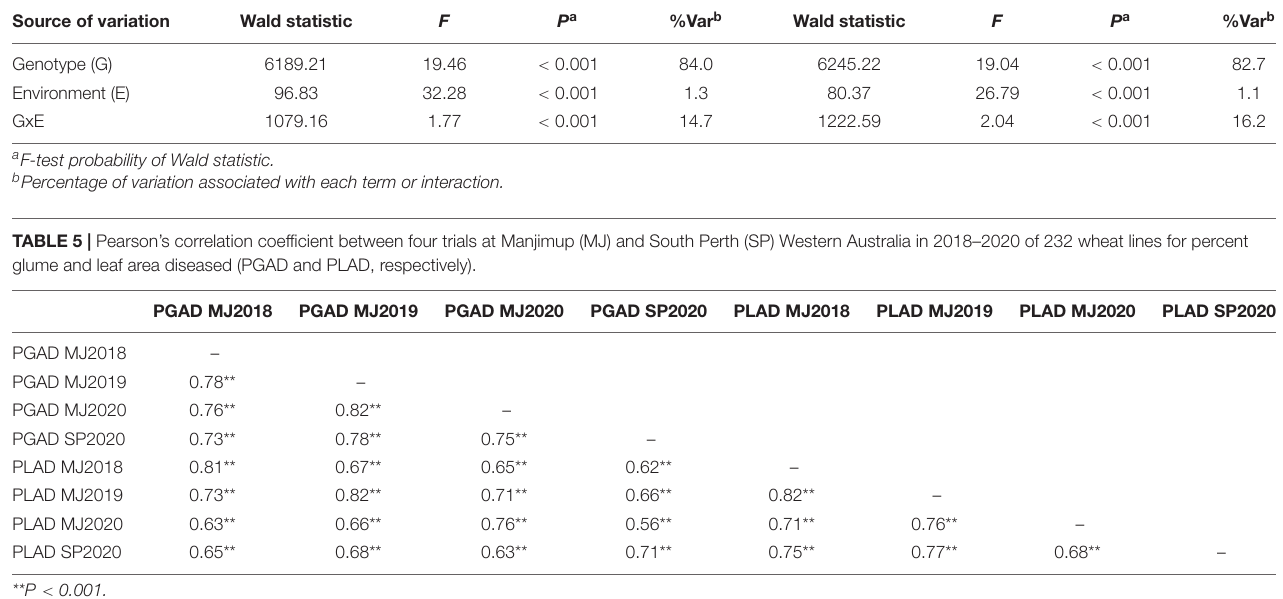
TABLE 4 | Linear mixed model analysis for genotypes, environments and their interactions with respect to percent glume and leaf area diseased (PGAD and PLAD, respectively) for 232 wheat lines evaluated in four environments in Western Australia in 2018–2020. PGAD